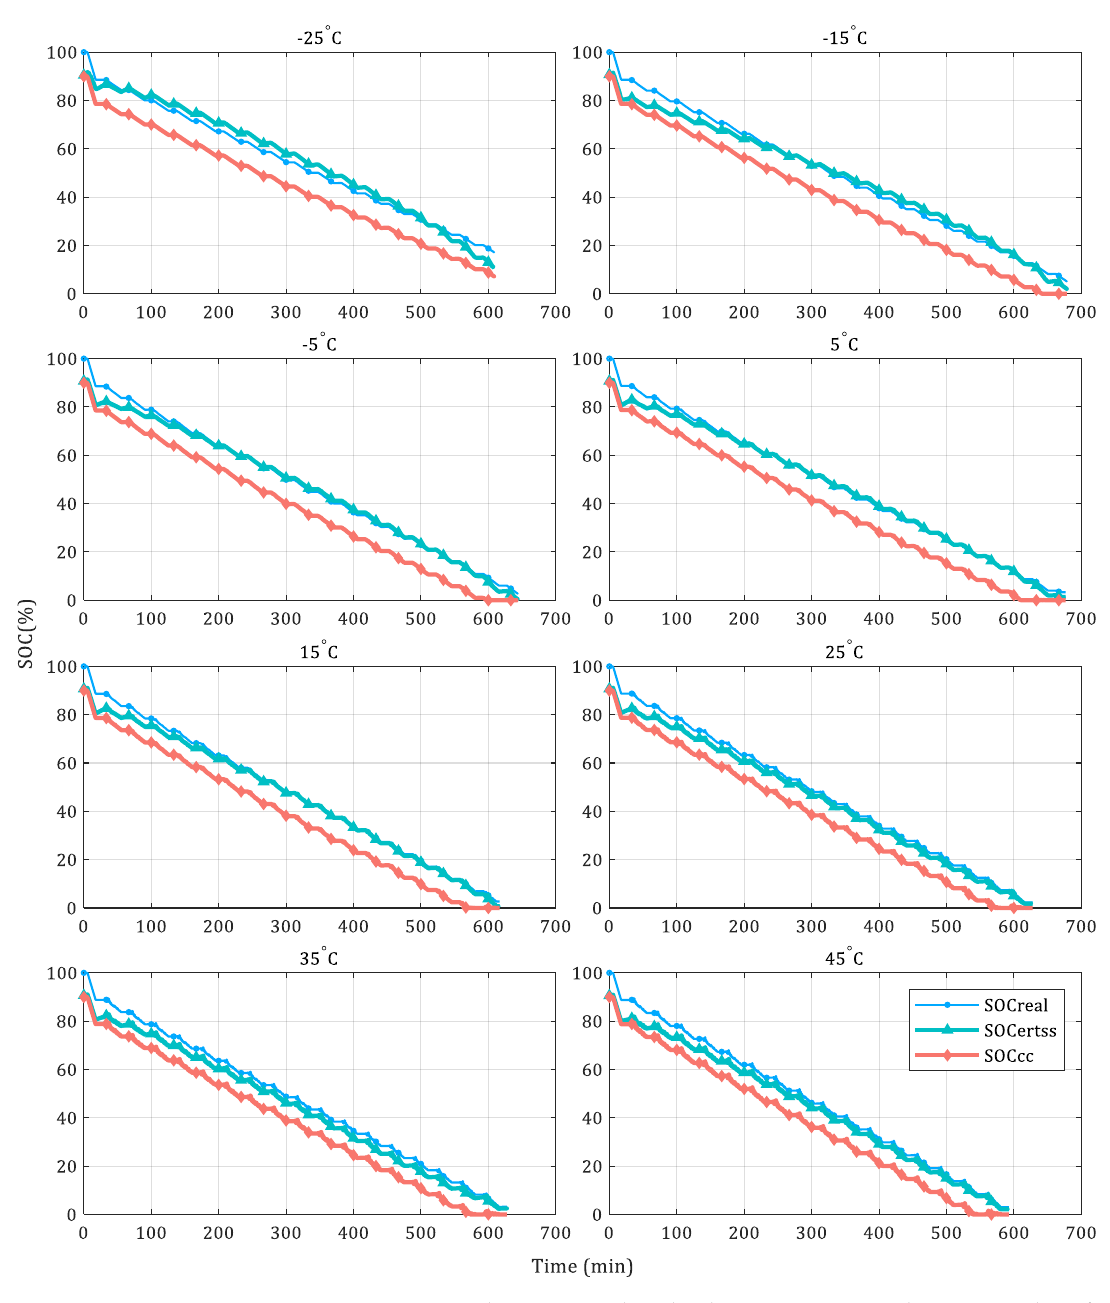
Figure 8. SOC estimation by ERTSS and coulomb counting. SOCreal represents the reference SOC, SOCertss represents ERTSS SOC estimation, and SOCcc represents coulomb counting (CC) SOC esti-